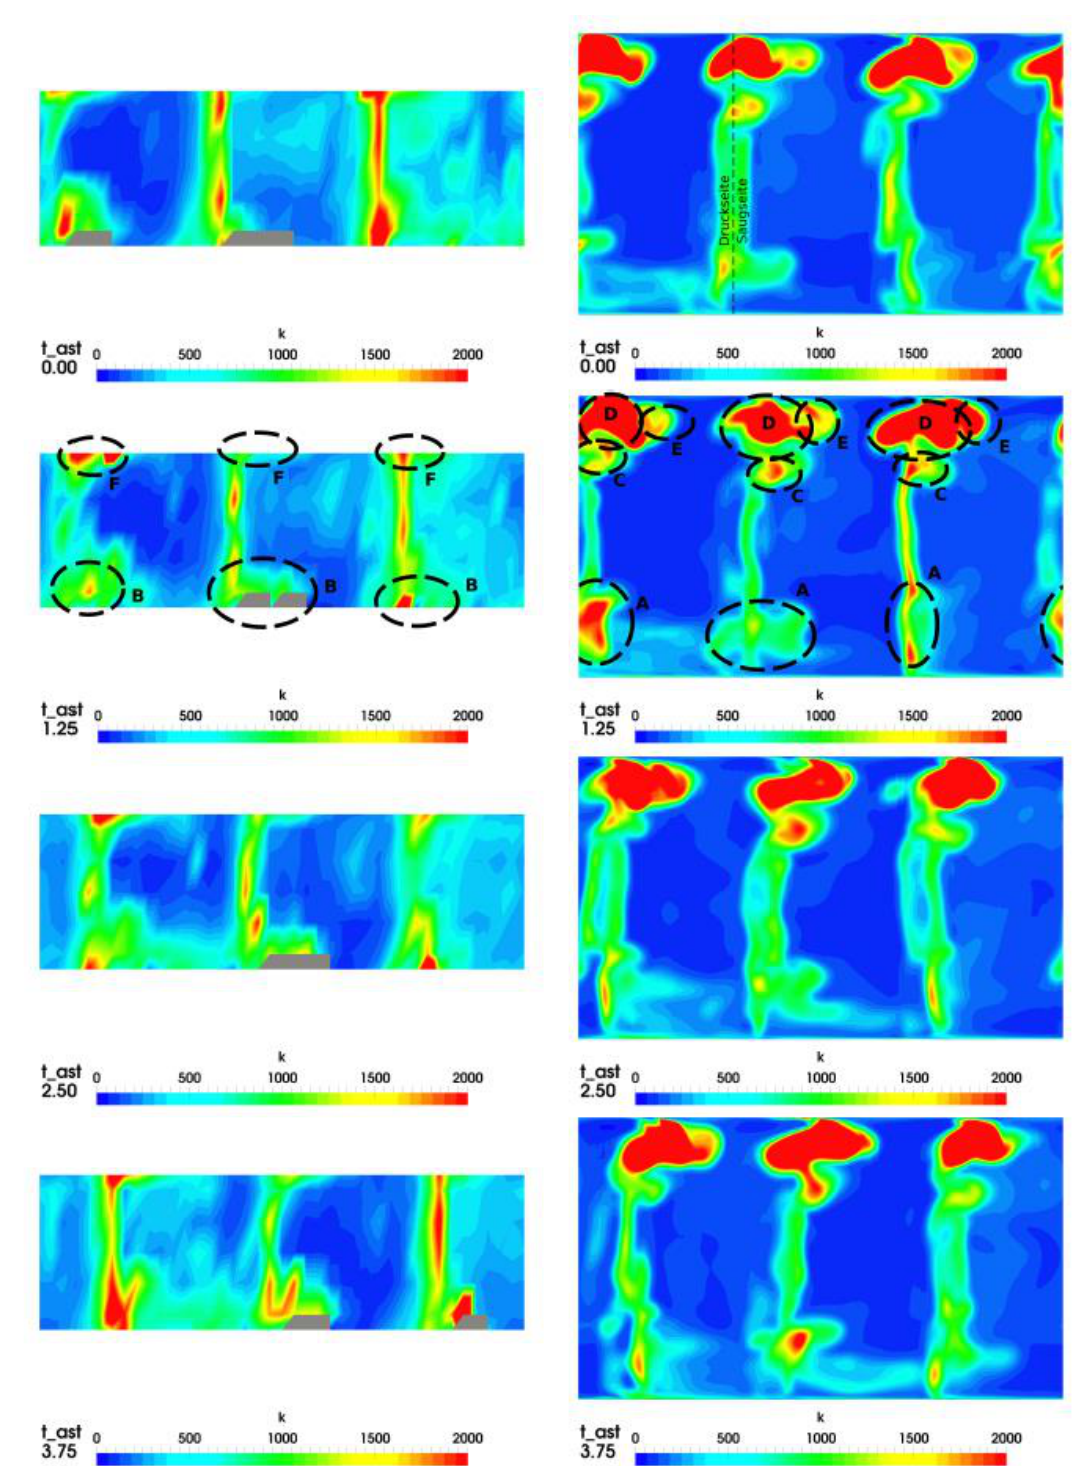
Figure 11. Comparison of instantaneous measured ( left ) and computed ( right ) turbulence kinetic energy in plane C1 after the rotor (view in upstream